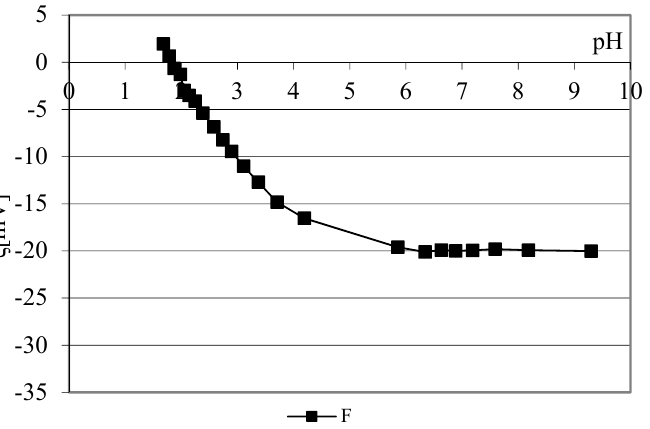
Figure 3. Zeta potential of reference cotton fabric (F) depending on pH of 1 mmol/L KCl.